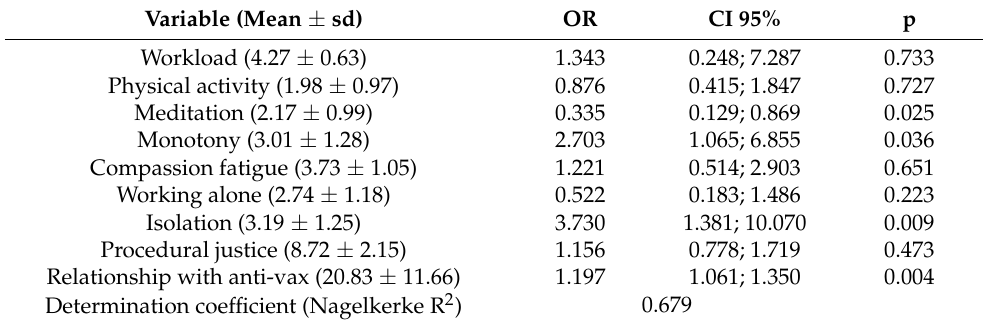
Table 2. Impact of changes in work patterns on occupational stress (ERI > 1) during the 4th pandemic phase. Odds ratios (aOR) and Confidence Intervals at 95% (CI 95%) adjusted for age and sex: 95 cases. Variable (Mean ± sd)